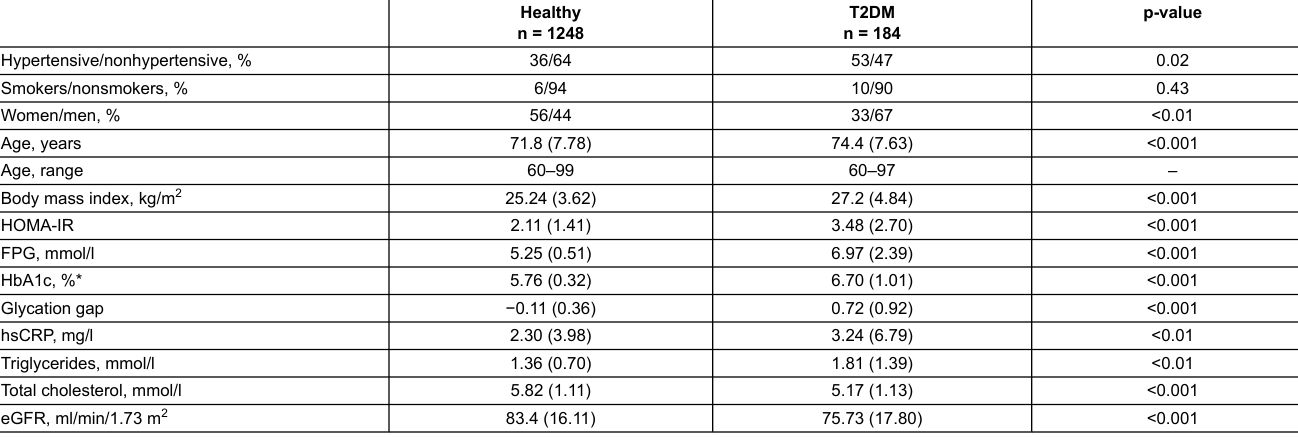
Table 1: Baseline characteristics of healthy and diabetic